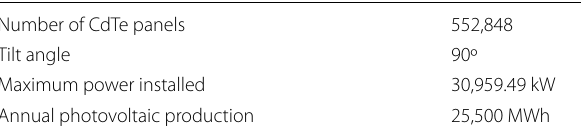
Table 4 Data for cadmium telluride photovoltaic system sizing for São Miguel